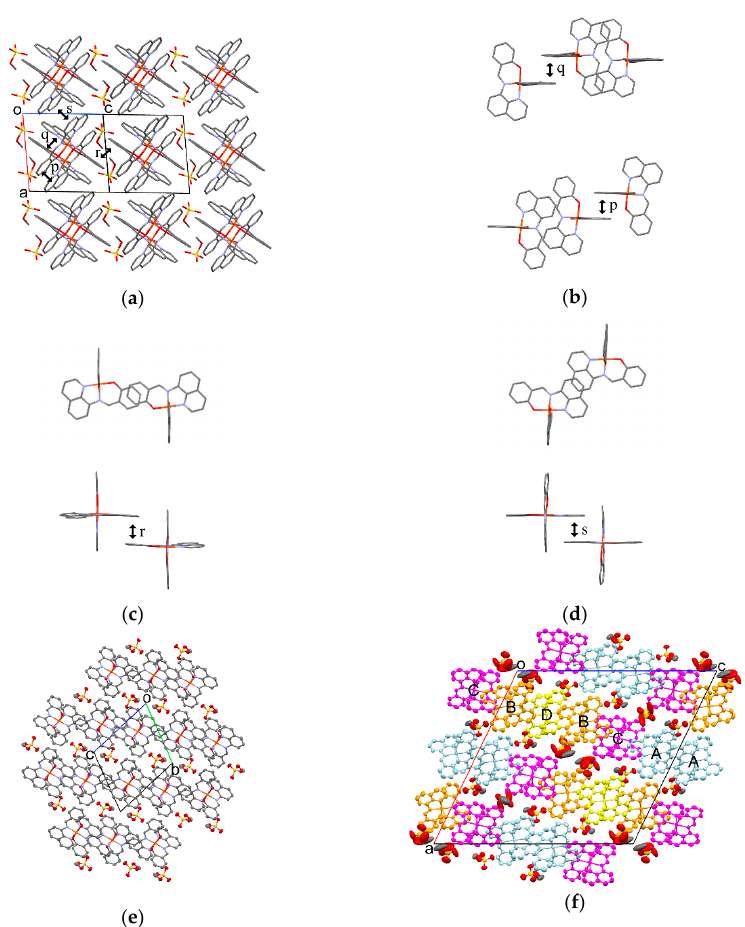
Figure 7. ( a ) Crystal structure viewed along the b − c direction of 1 at 293 K; Top (upper) and side (bottom) views of π -stacking structures of the [Fe(qsal) 2 ] cations for p ( b ), r ( c ), and s ( d ) at 293 K; ORTEP drawings of 1 with 50% probability at 293 K ( e ) and 425 K ( f ). The light blue, orange, magenta, and yellow [Fe(qsal) 2 ] cations correspond to cations A, B, C, and D, respectively. Hydrogen atoms are omitted for clarity.